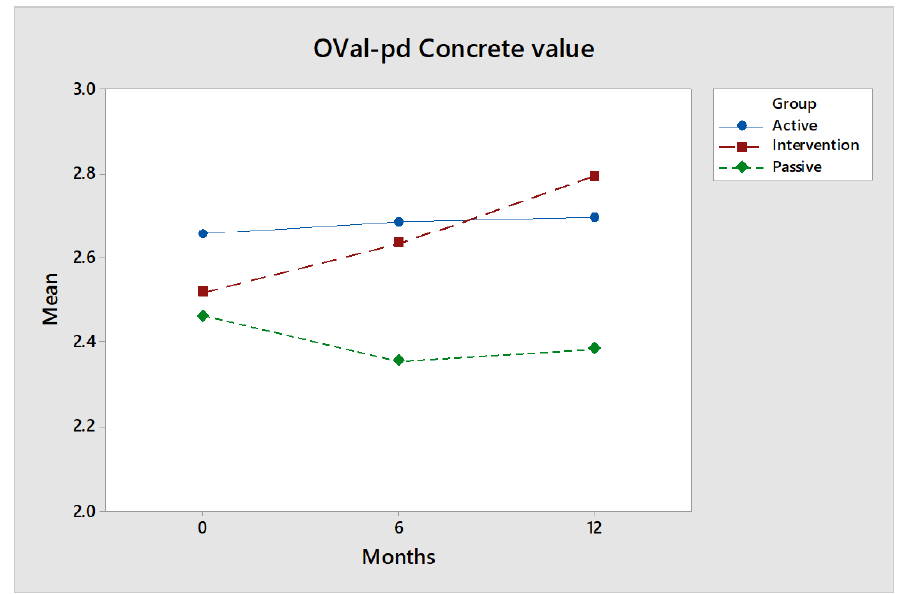
Figure 1. The Oval-pd concrete value for the intervention group (red) increases over time, while the values for the control groups (green and blue) are largely the same.